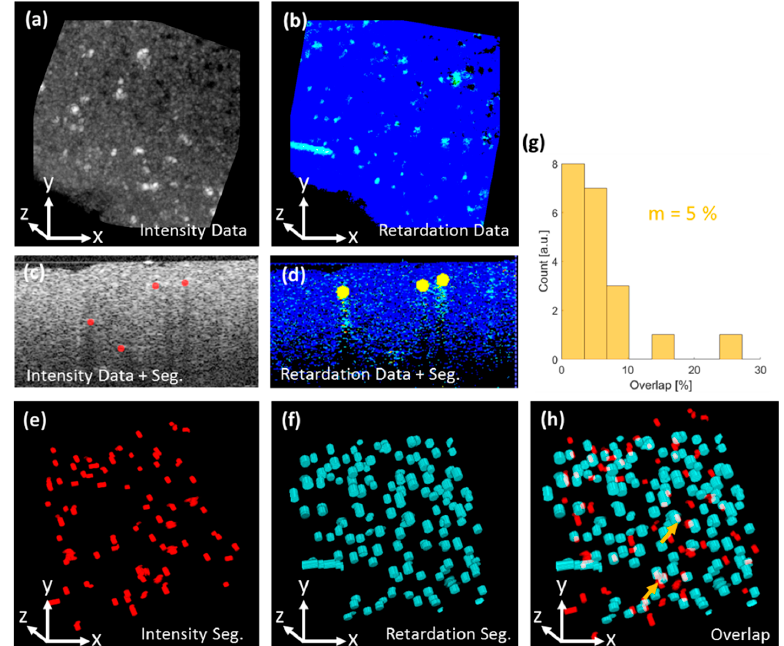
µ m. Color map: see